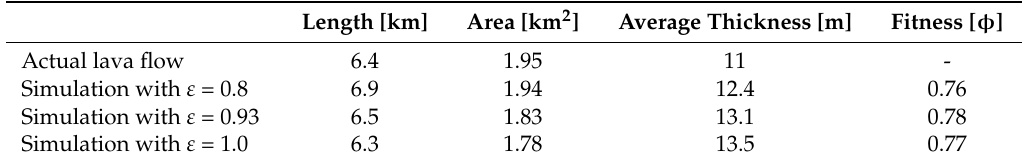
Table 3. Comparison between the morphological properties (length, area, and average thickness) of the 2001 Etna lava flow derived by field measurements [17] and numerical